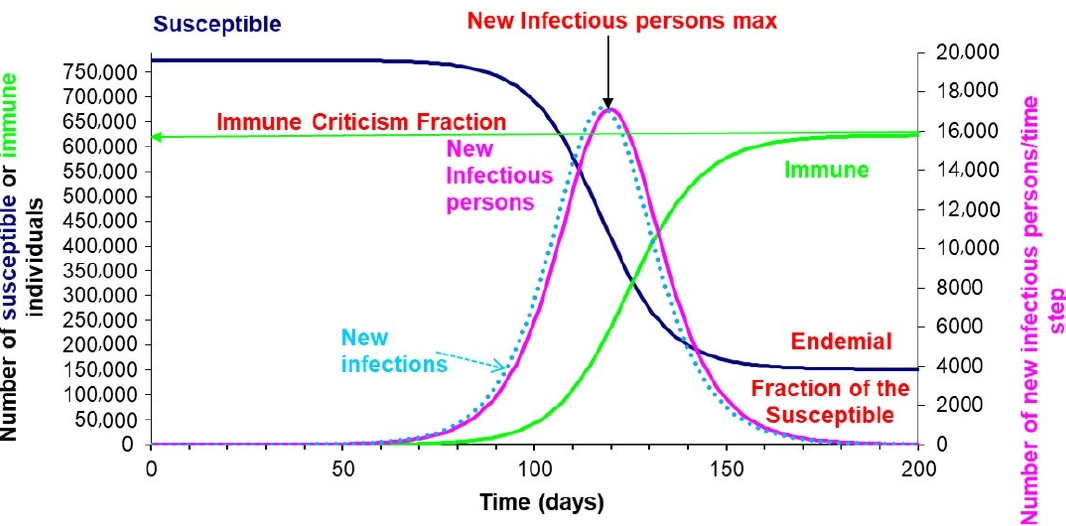
Figure 3. Susceptible, exposed, infected, and resistant (SEIR) model simulation of the coronavirus disease 2019 (COVID-19) propagation dynamics in a standard population with random circulation, with 770,000 susceptible, one infectious, and zero recovered at time 0. Key input parameters in the model: Average pre-infectious period (days) = 2, Average duration of infectiousness (days) = 5.6, and R0 = 2 [44].